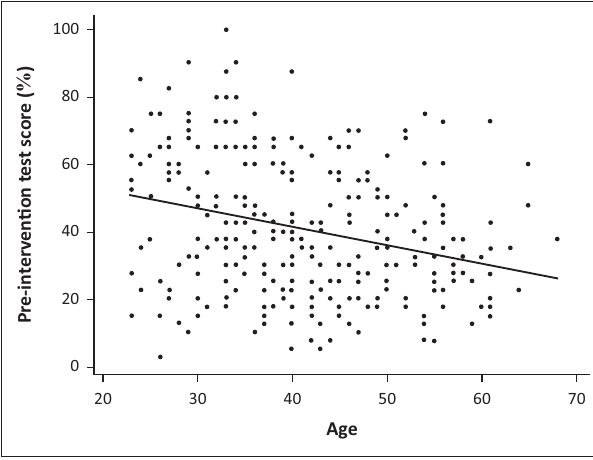
FIGURE 2: Correlation between age and pre-intervention test score.